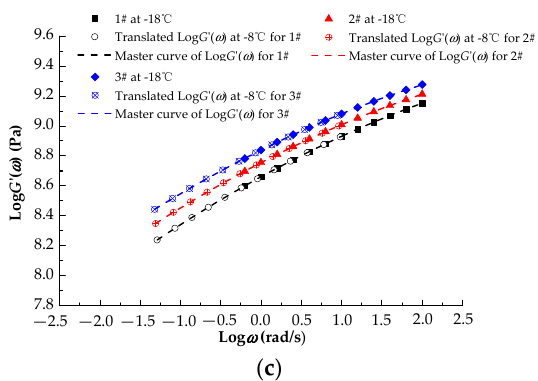
Figure 5. Master curves of storage modulus ( ) G ω′ for different aging levels. ( a ) RTFOT; ( b ) 1 pressurized aging vessel (PAV); ( c ) 2PAV.